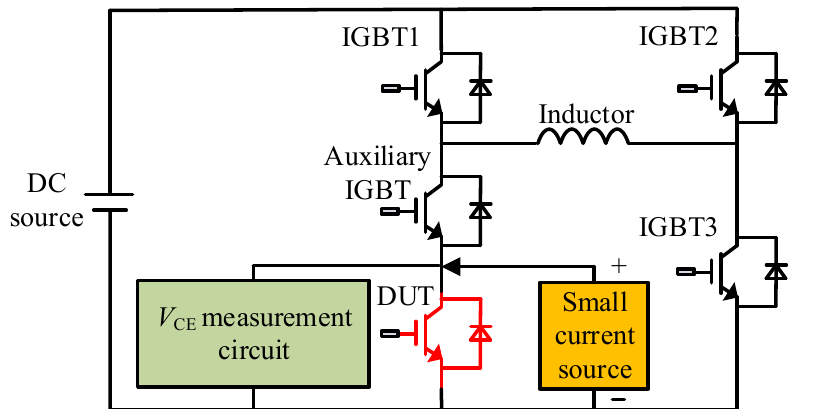
Figure 15. Power cycling circuit.